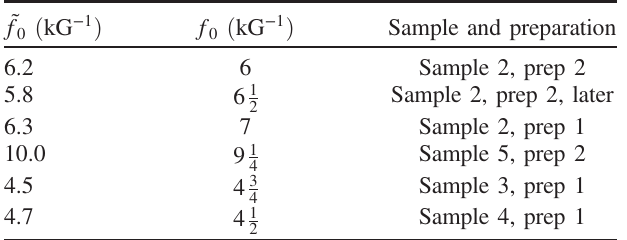
TABLE II. Comparison of frequencies fit of the ν ¼ 5 = 2 spectral data to f 0 observed at ν ¼ 3 for each sample and